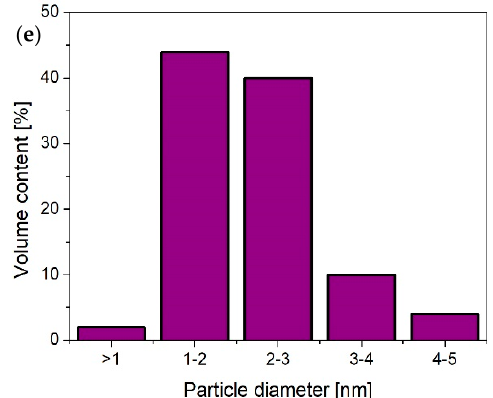
Figure 3. Transmission electron microscopy (TEM) images of ( a ) Pt-TiO 2 _2_C, ( b ) Pt-TiO 2 _2_T and metal particles size distribution for ( c ) Pt-TiO 2 _2_C, ( d ) Pt-TiO 2 _2_T and ( e ) Cu / Pt-TiO 2 _2_C.